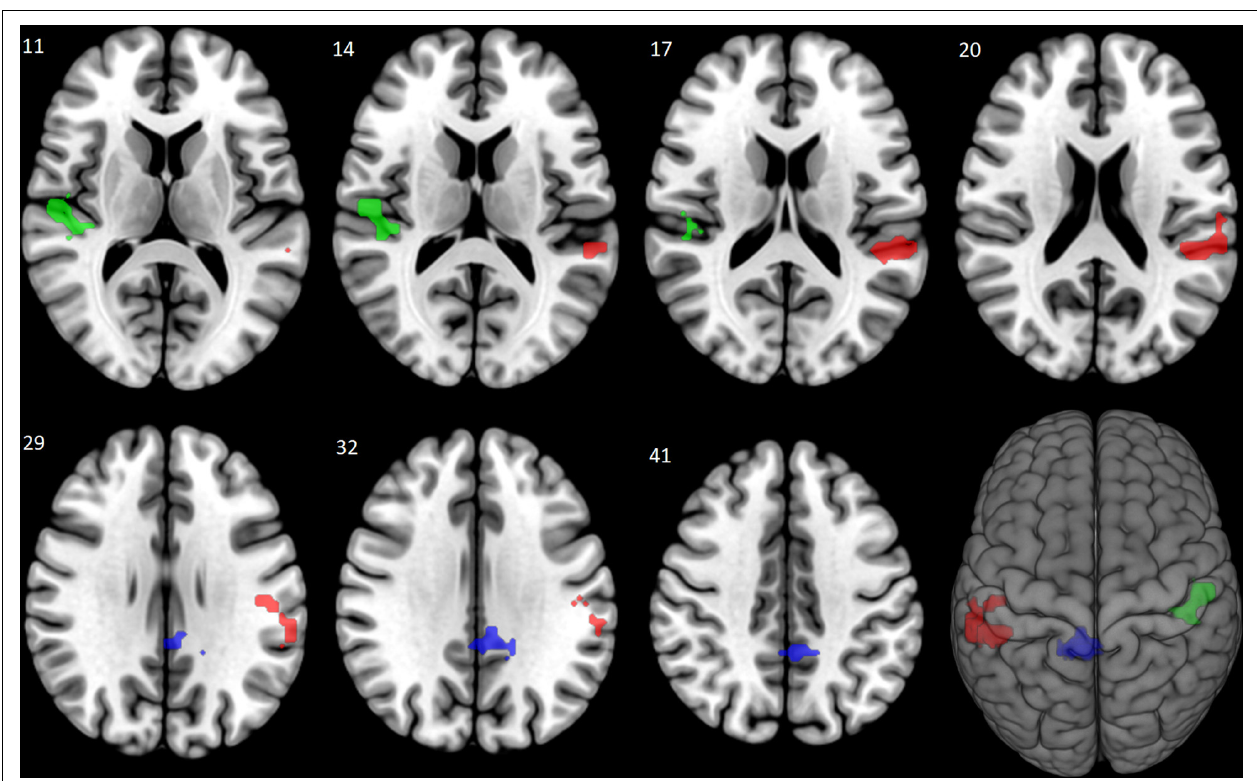
FIGURE 1 | Increased brain activation to fearful faces: Evening start > Morning start (Study 1). The Evening start M circ subgroup showed increased brain activation compared to the Morning start subgroup in response to fearful faces. The significantly activated three clusters are shown (in corresponding order shown in Table 3 ) with red (left superior temporal, left supramarginal and left postcentral gyri), green (right superior temporal gyrus, right Rolandic operculum and right Heschl’s gyrus), and blue (left middle and left posterior cingulate gyri, right precuneus) colors at a cluster level p FWE < 0.05, corrected for multiple